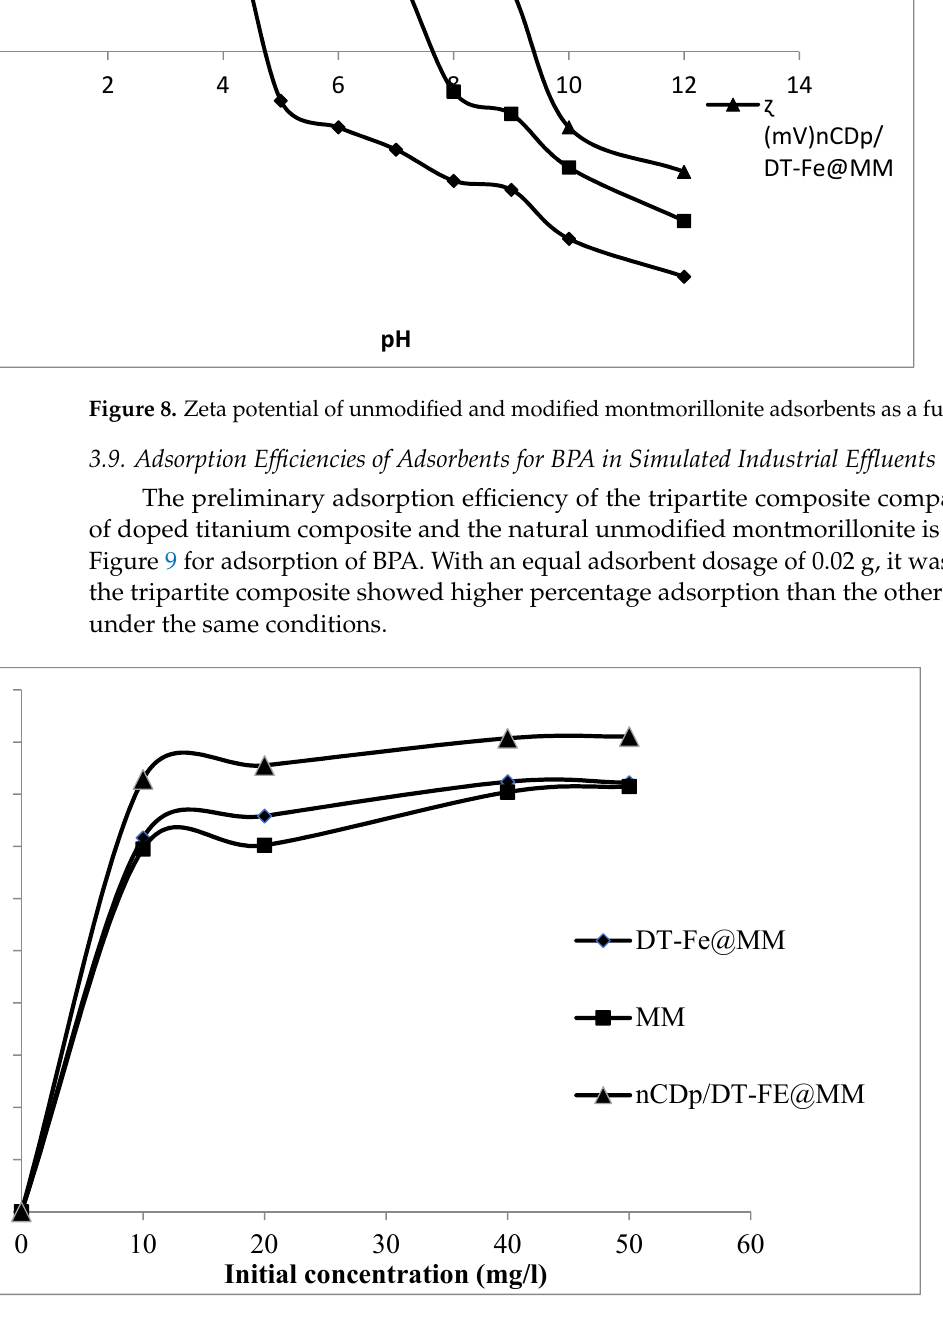
Figure 9. Percentage Adsorption of BPA unto Untreated Montmorillonite (MM), Doped titanium composite (DT-Fe@MM) and Tripartite montmorillonite composite (nCDp/DT-Fe@MM).